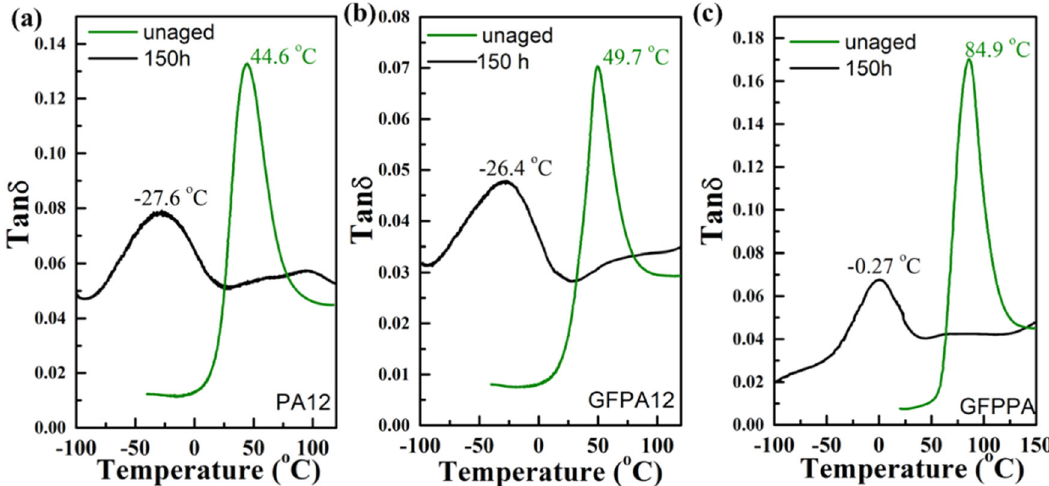
Fig. 3 Glass transition of the samples. Tan δ curves of unaged and 150 h-aged PA12 ( a ), GF23-PA12 ( b ), and GF30-PPA ( c ) samples.